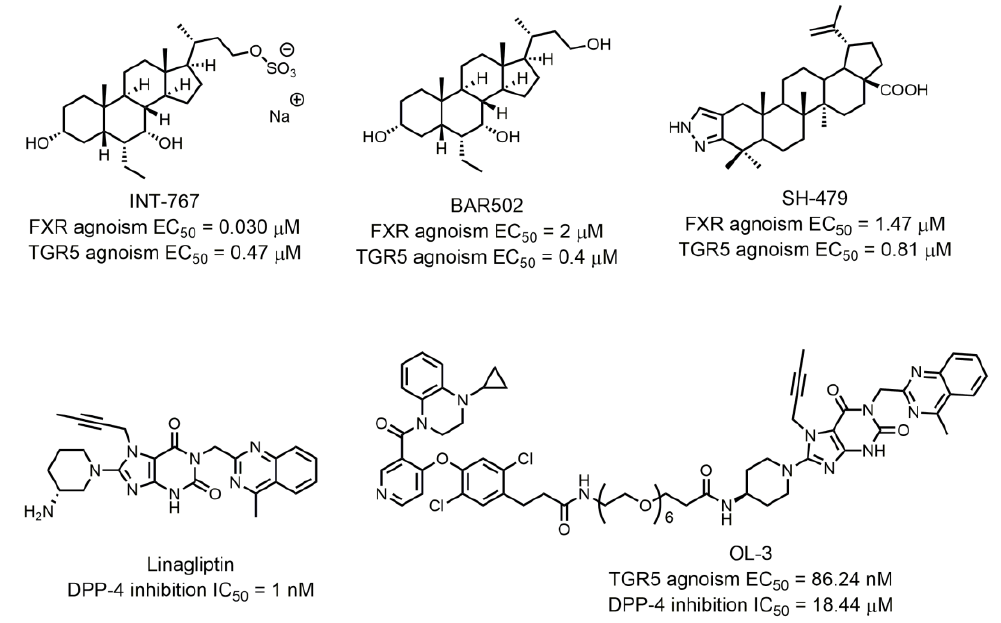
FIGURE 7: FXR and TGR5 dual targeting agonists and other dual targeting com-